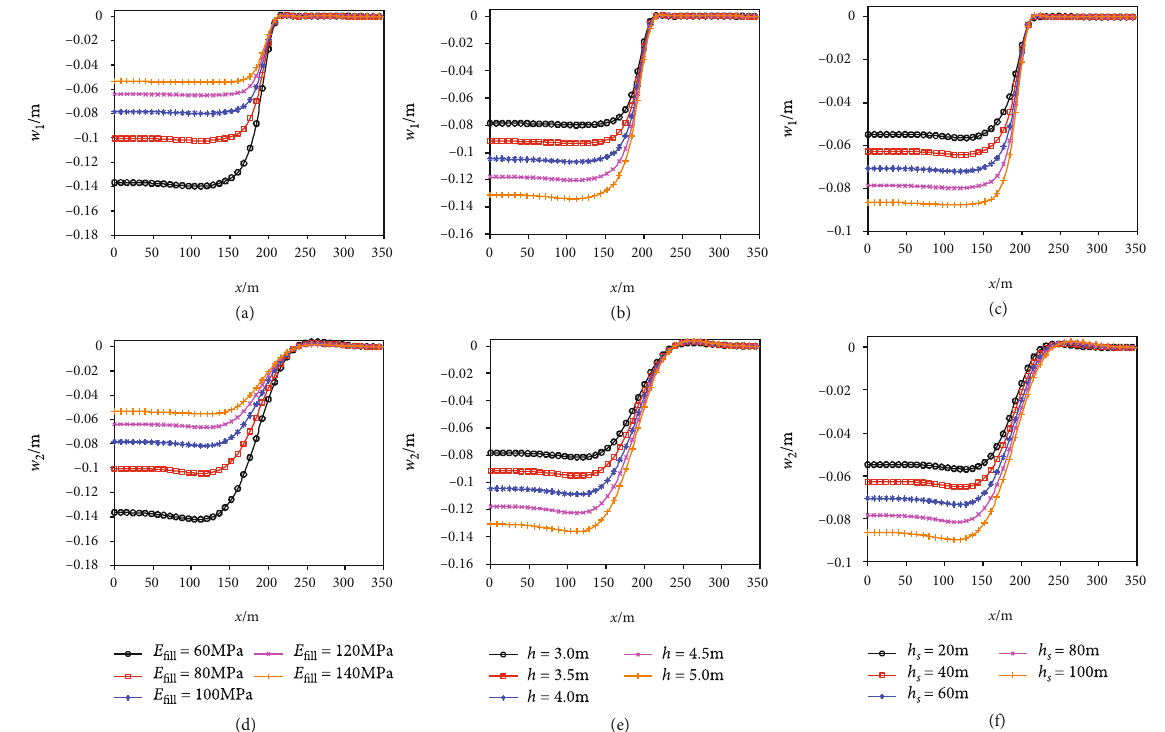
Figure 5: The curves of key strata subsidence with the distance to the middle of the stope under various (a, d) elastic modulus of back fi ll, (b, e) mining height, and (c, f) thickness of soft